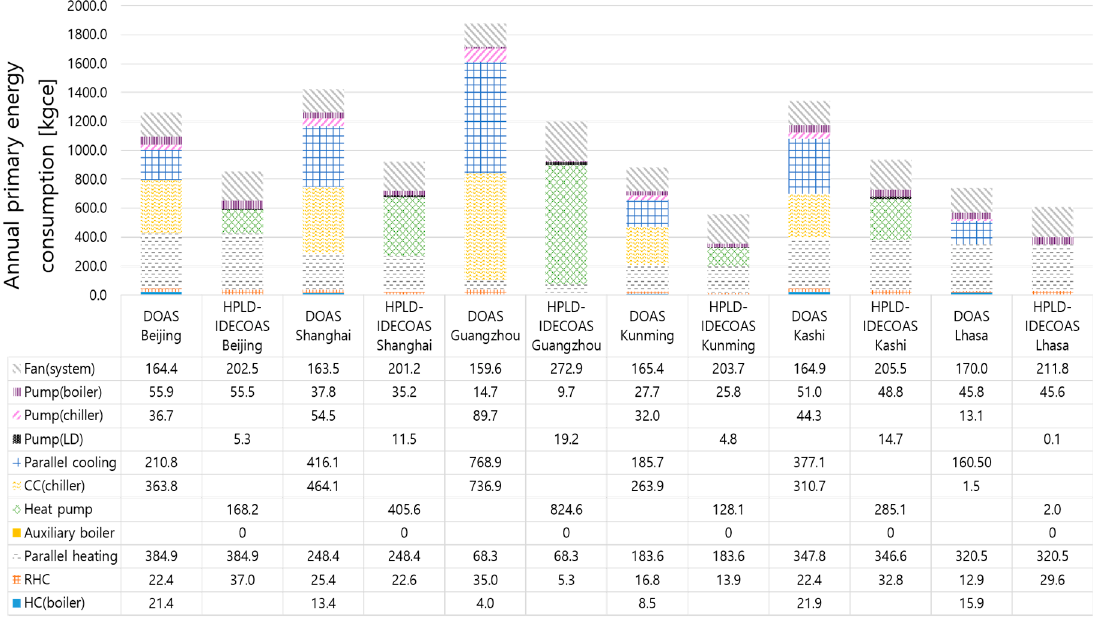
Figure 25. Comparison of annual energy consumption.